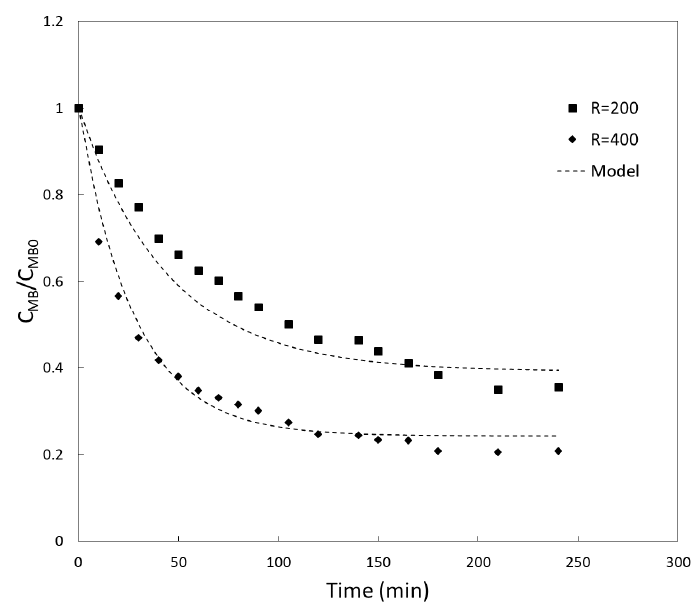
Figure 8. Adsorption kinetics of methylene blue on yerba mate at 298 K for R = 200 and R = 400. The dashed lines represent how the model (with q max b = 0.44 (L / g) and k C = 3.5 × 10 − 5 (dm / min)) predicts the trend of adsorption.